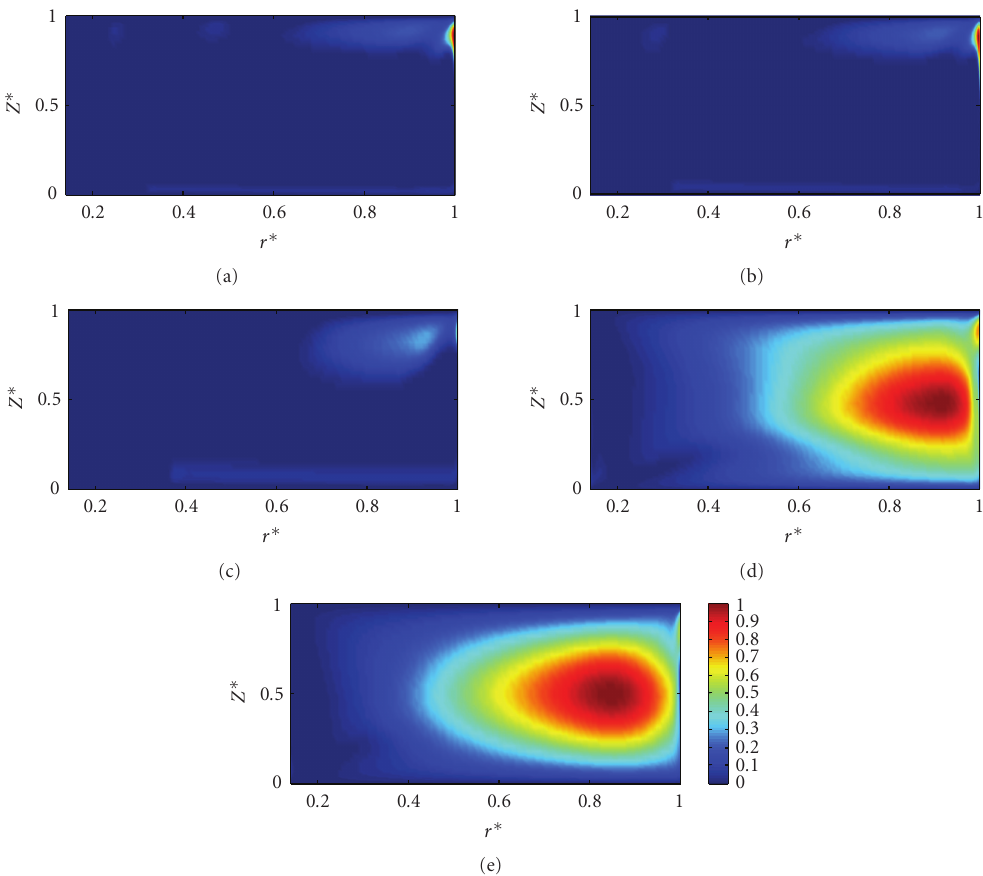
Figure 12: Influence of the aspect ratio on the isovalues of the turbulence Reynolds number Re t = k 2 / ( ν ε ) (normalized by its maximum ) for various sets of flow parameters (Re, G ): (a) (1 . 8 × 10 5 , 0.05), Re t value Re t max = 57 . 61; (d) (5 × 10 6 , 0.04), Re (1 . 8 × 10 5 , 0.02), Re t max